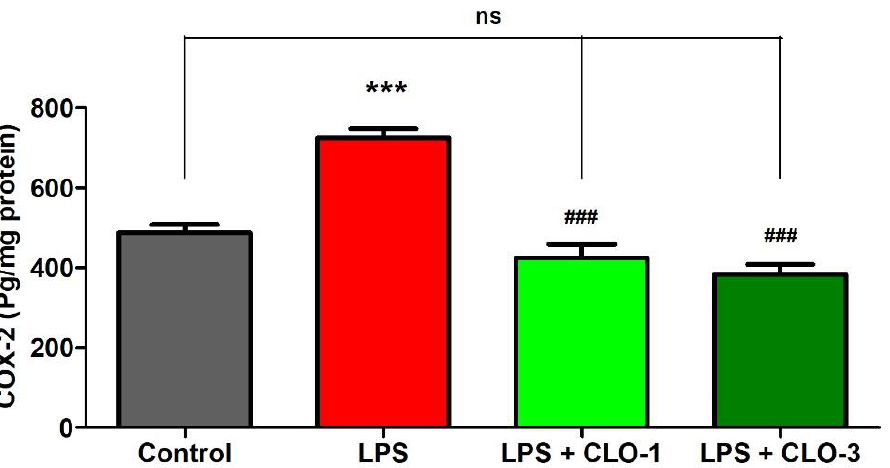
Figure 4. Effect of clobenpropit (CLO) on cyclooxygenase-2 (COX-2) levels in lipopolysaccharide (LPS)-induced mice brains. LPS-CLO-1 and LPS-CLO-3 refer to administration of clobenpropit (1 or 3 mg/kg, p.o., respectively) and lipopolysaccharides (250 µ g/kg, i.p.). CLO treatment reduced the activity of COX-2 induced by LPS. The results are expressed as mean ± SEM ( n = 6). One-way ANOVA ( F (3,20) = 33.67, p < 0.001) was followed by Tukey–Kramer multiple comparisons tests. *** p < 0.001 as compared to the control group; ns, not significant as compared to the control group; ### p < 0.001 as compared to the LPS-treated group.